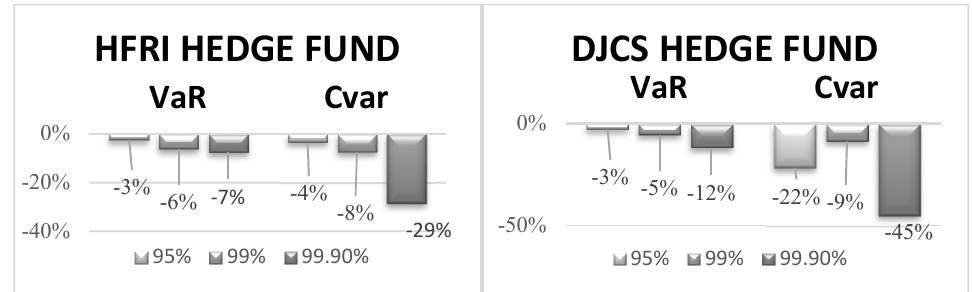
Figure 2. VaR vs. CVaR-HFRI and DJCS hedge fund.